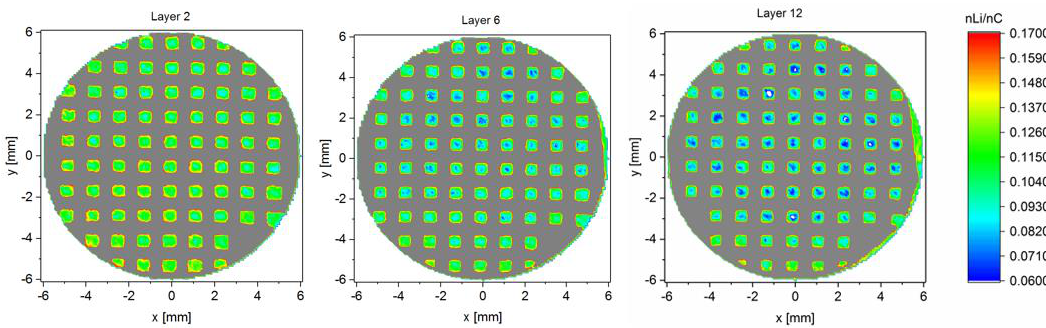
Figure 6. Lithium concentration of a model electrode at layer 2, 6, and 12.